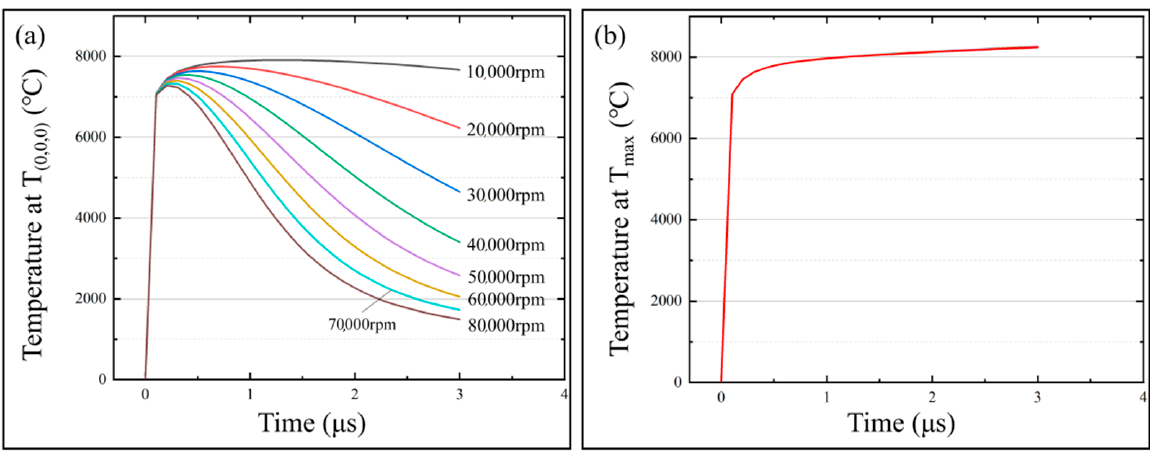
Figure 13. Micro-bit wear volume ( V m ) under different pulse width.